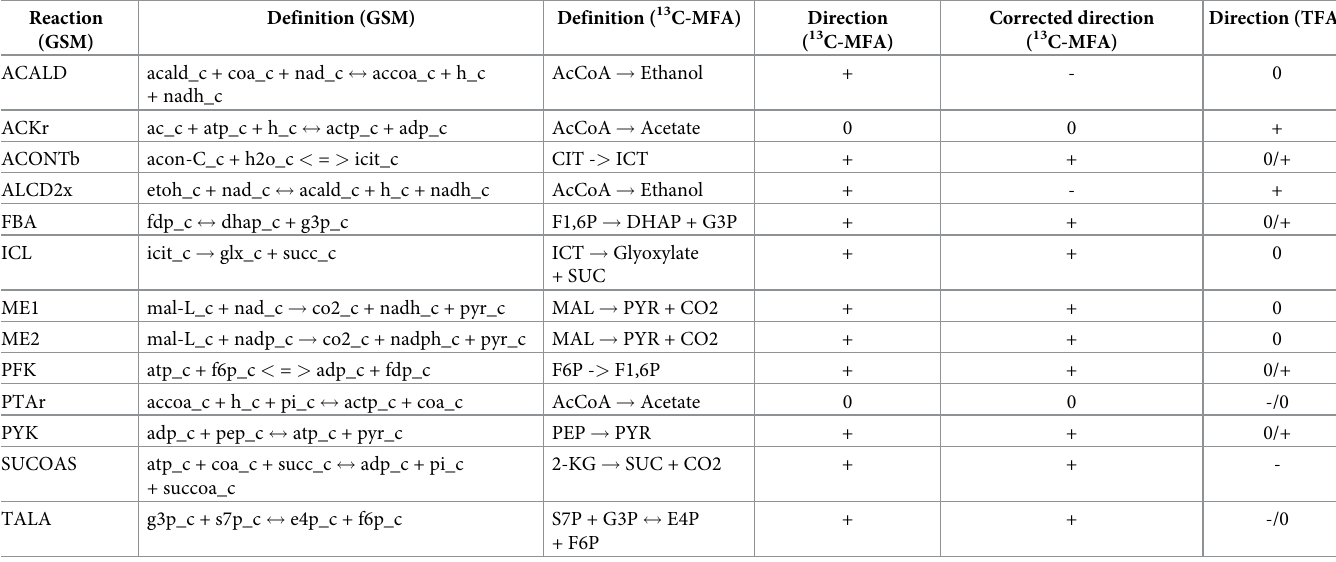
Where + , flux in the forward direction; - , flux in the reverse direction; 0, no flux. Corrected direction , refers to the adjustments due to differences in the definition of the reaction between 13 C-MFA and GSM (S1 Table). For example the case of ALCD2x: in vivo flux ( 13 C-MFA) suggests production of ethanol, whereas the in silico one (GSM/TFA) predicts consumption of ethanol. Since reactions are defined in opposite directions, a correction becomes necessary. Discrepancy between corrected directions and predicted ones allowed an automated identification of flux pattern